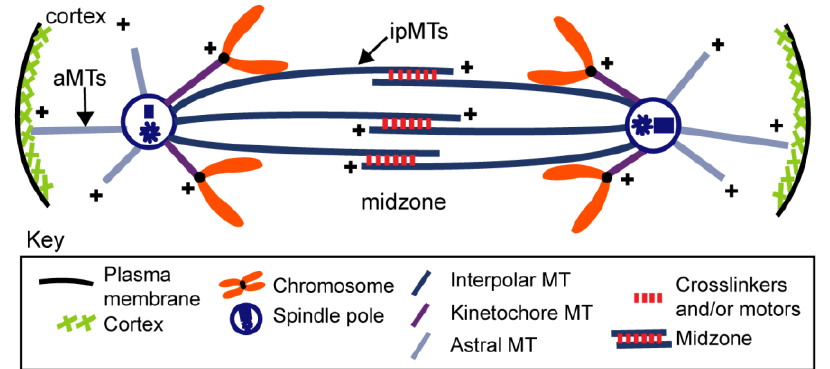
Figure 1. Basic structure of the anaphase B spindle. The major components driving anaphase B spindle elongation are shown, namely ipMTs and the spindle midzone as well as aMTs and the cell cortex, and the structural polarity of spindle MTs is indicated by marking their plus ends. For simplicity, branched augmin-nucleated and chromatin-nucleated MTs that do not reach the poles, as well as pole-nucleated MTs that do not reach kinetochores or the midzone, are not included. Also, anastral spindles lacking centrosomes at the poles are not represented here.